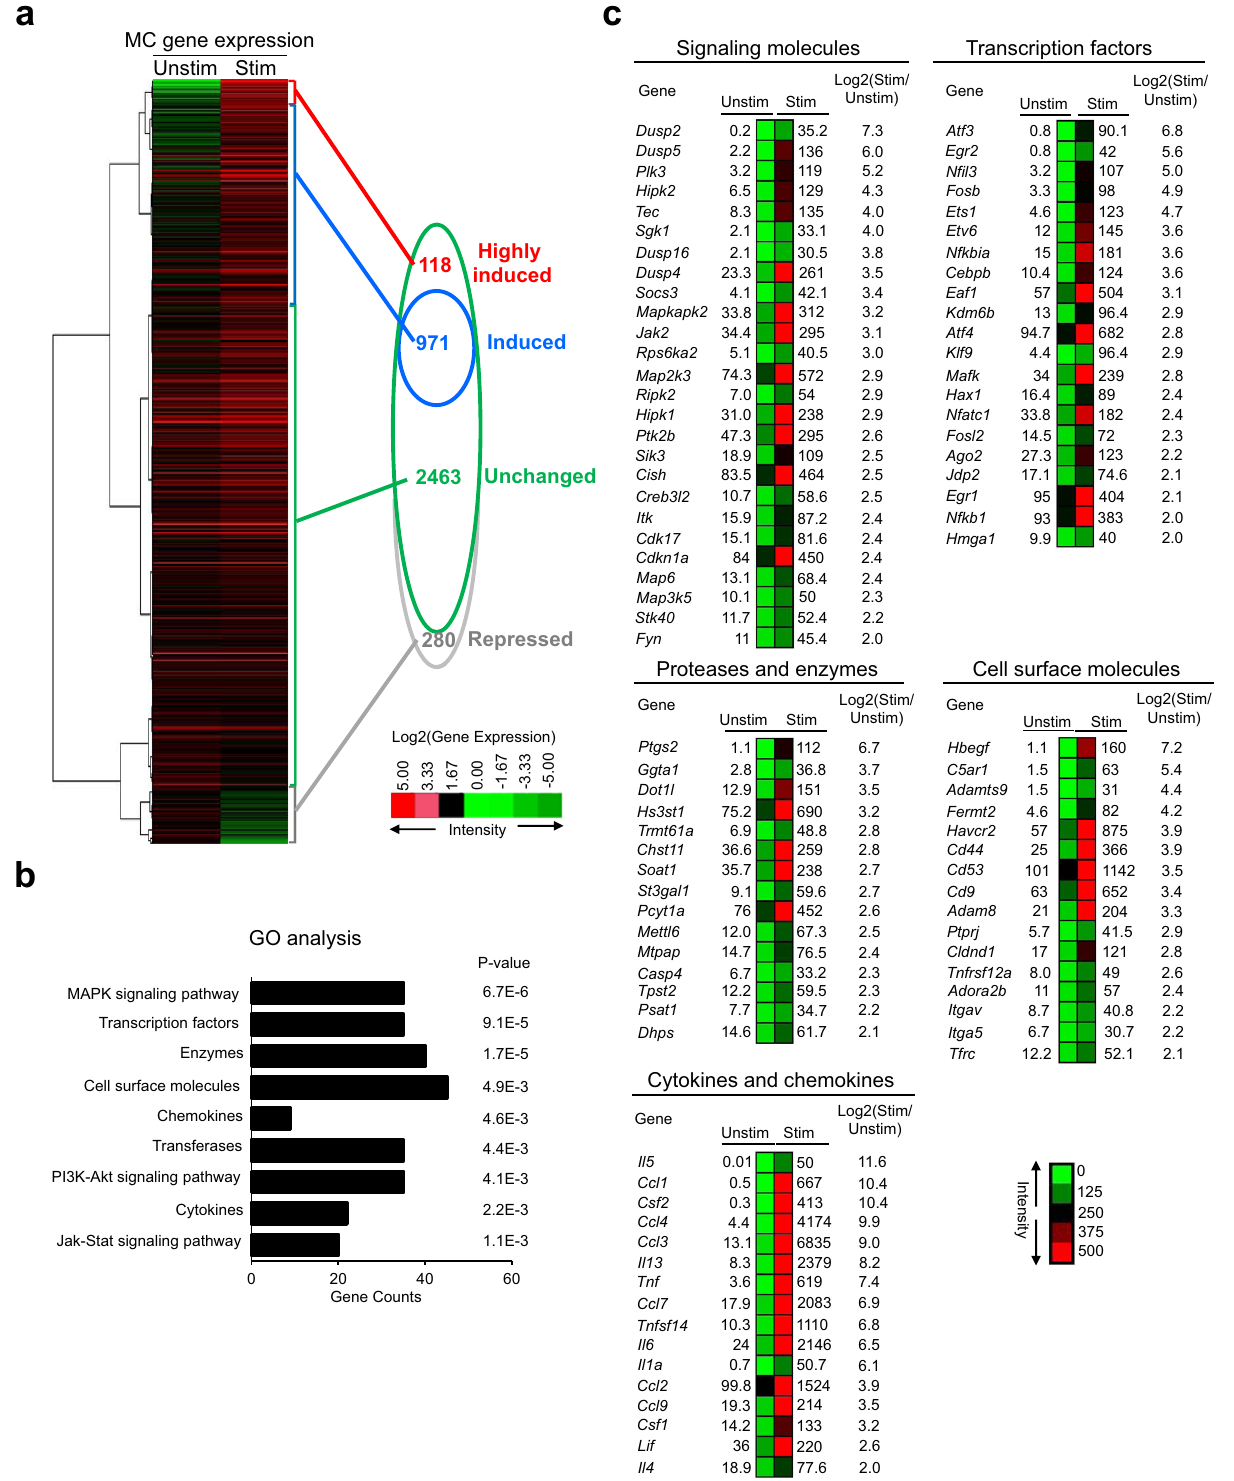
Fig. 4 IgE receptor crosslinking induces expression of genes that encode signaling molecules, Proteases and enzymes, transcription factors, MC surface molecules, cytokines and chemokines. a Heatmap presentation of the RNA transcripts after IgE receptor crosslinking for two hours. Unstim: unstimulated; Stim: stimulated. “ Highly induced ” means that the fold of induction (Stim vs Unstim) is higher than 10, “ induced ” means that the fold of induction ranges from 2 to 10, “ unchanged ” means that the fold of change is higher than 0.5 and lower than 2 and “ repressed ” means that the fold of change is lower than 0.5. b DAVID gene ontology enrichment analysis of the activation-induced genes. P -values were calculated by a one-side Fisher ’ s exact test with the adjustment of Benjamini-Hochberg method. c Heatmap representations of top activation-induced genes. The numbers indicate RNA reads (RPKM). Data a – c represent three biological